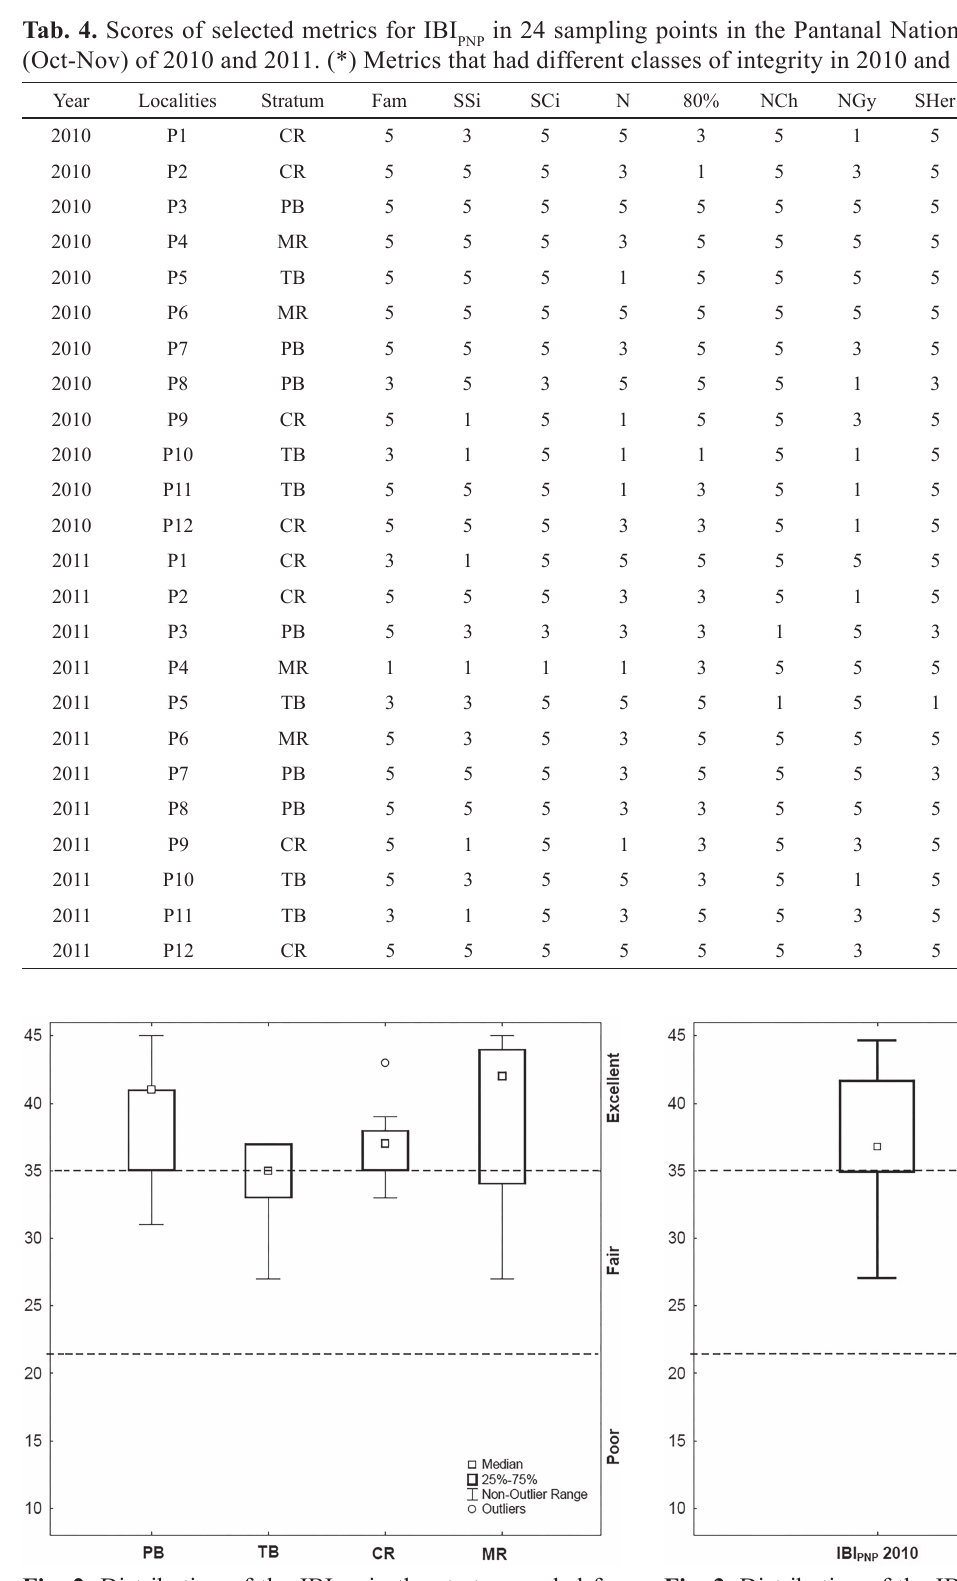
Fig. 3. Distribution of the IBI 2011.